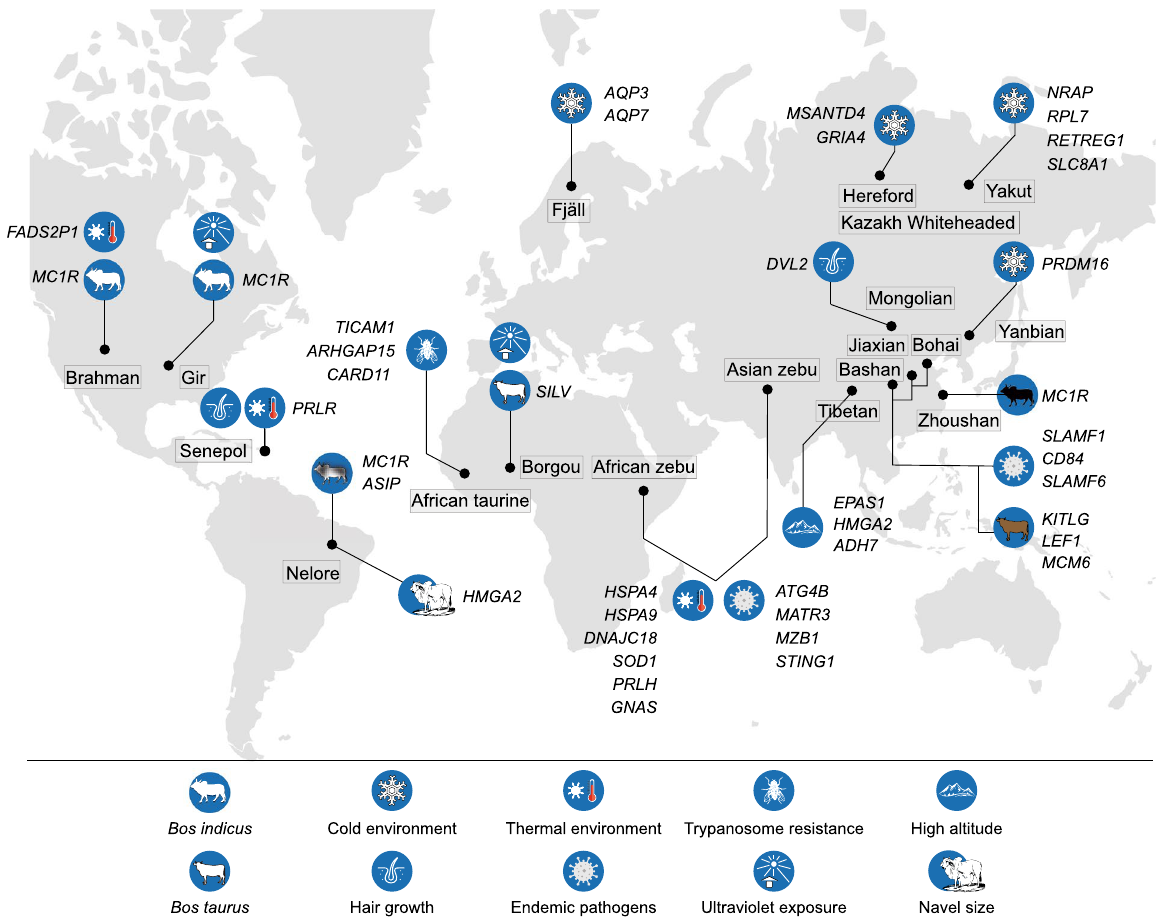
Fig. 2 Examples of local adaptations in cattle breeds/populations, each labelled with the candidate gene or genes under